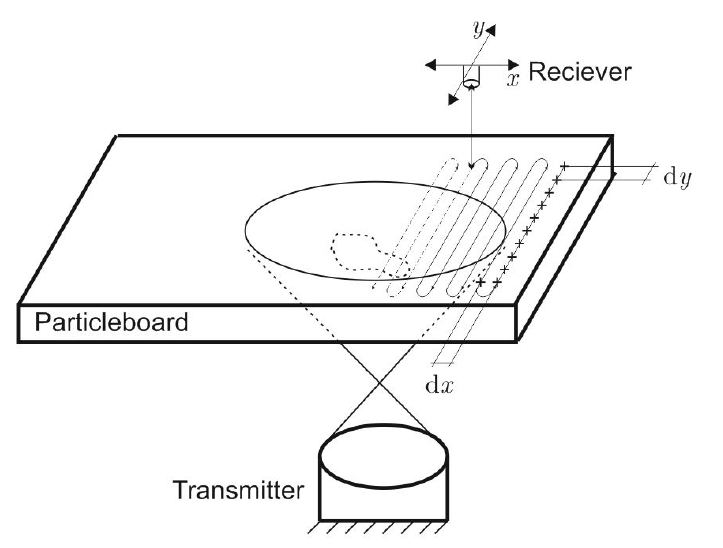
Figure 2. Schematic experimental setup with a flaw imitation at the top of the wooden particleboard.